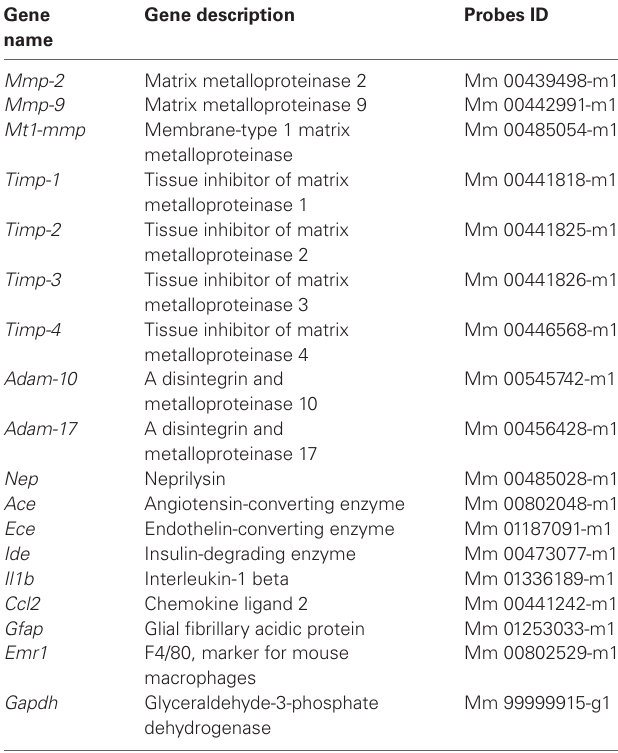
Table 1 | Summary of TaqMan mouse probes used for quantitative PCR